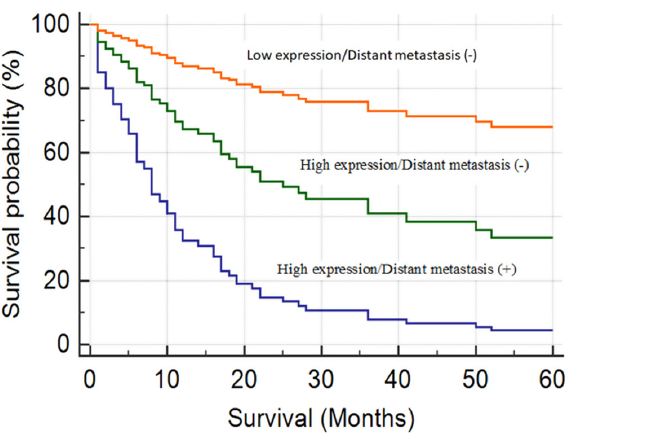
Figure 7. Heat shock-related 70-kDa protein 2 expression/distant metastasis status (Cox regression